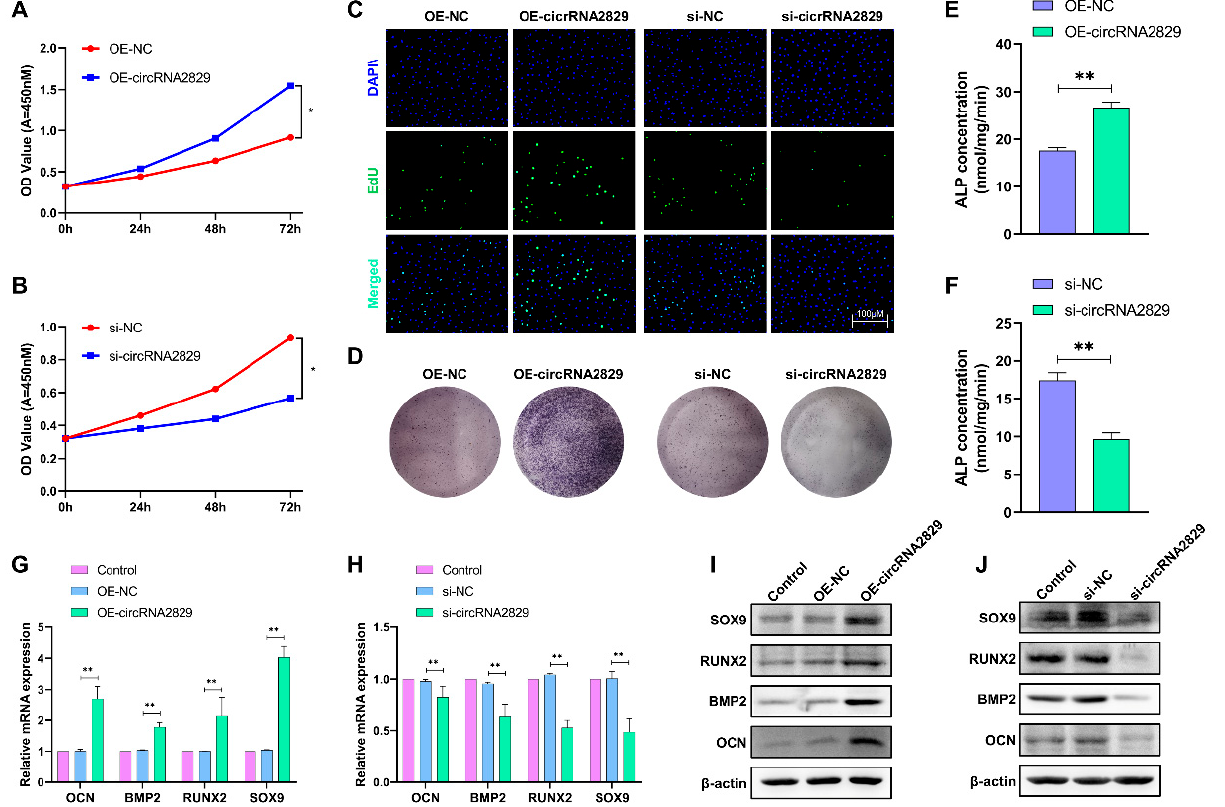
Figure 6. circRNA2829 promotes chondrocyte proliferation and osteogenic differentiation. After transfection of OE-circRNA2829 or si-circRNA2829 in chondrocytes, CCK-8 ( A , B ) and EdU ( C ) were used to determine cell proliferation ability; BCIP/NBT staining ( D ) and ALP viability assay ( E , F ) to assess the osteogenic differentiation ability of chondrocytes; RT-qPCR ( G , H ) and Western blot ( I , J ) to detect changes in the transcriptional and translational levels of osteogenic marker-related genes. ** p < 0.01, * p < 0.05.